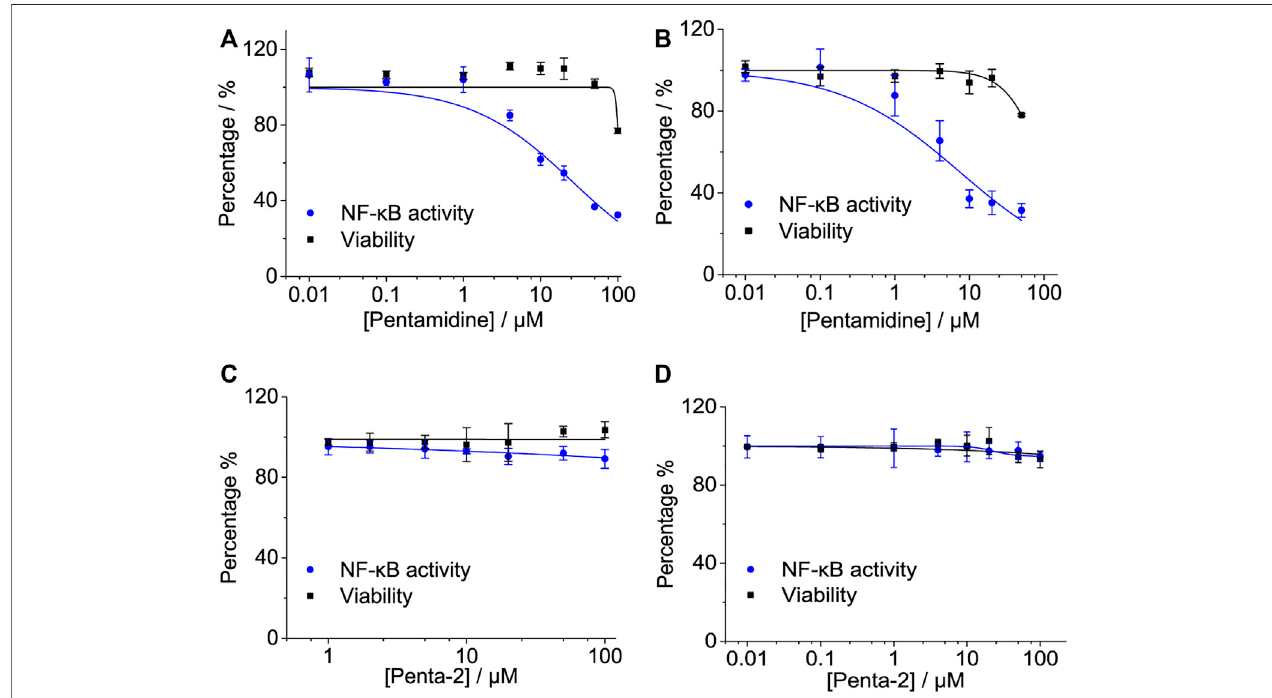
FIGURE 3 | Effects of pentamidine and penta-2 on LPS-induced NF- κ B activity. HEK-Blue hTLR4 cells, which over-express human CD14, TLR4, and MD2, were stimulated with 20 ng ml − 1 LPS and indicated concentrations of pentamidine (A) and penta-2 (C) . The NF- κ B activity was determined by SEAP assay, and cellular viability was measured by CCK-8 Kit. BV-2 NF- κ B luciferase reporter cells were treated with 200 ng ml − 1 LPS and the indicated concentrations of pentamidine (B) and penta-2 (D) . After 24 h of incubation, the NF- κ B activity was determined by the Dual-Glo luciferase assay, and cellular viability was measured by crystal violet staining. All experiments were performed 3 – 4 times independently, and data were given as the mean ±